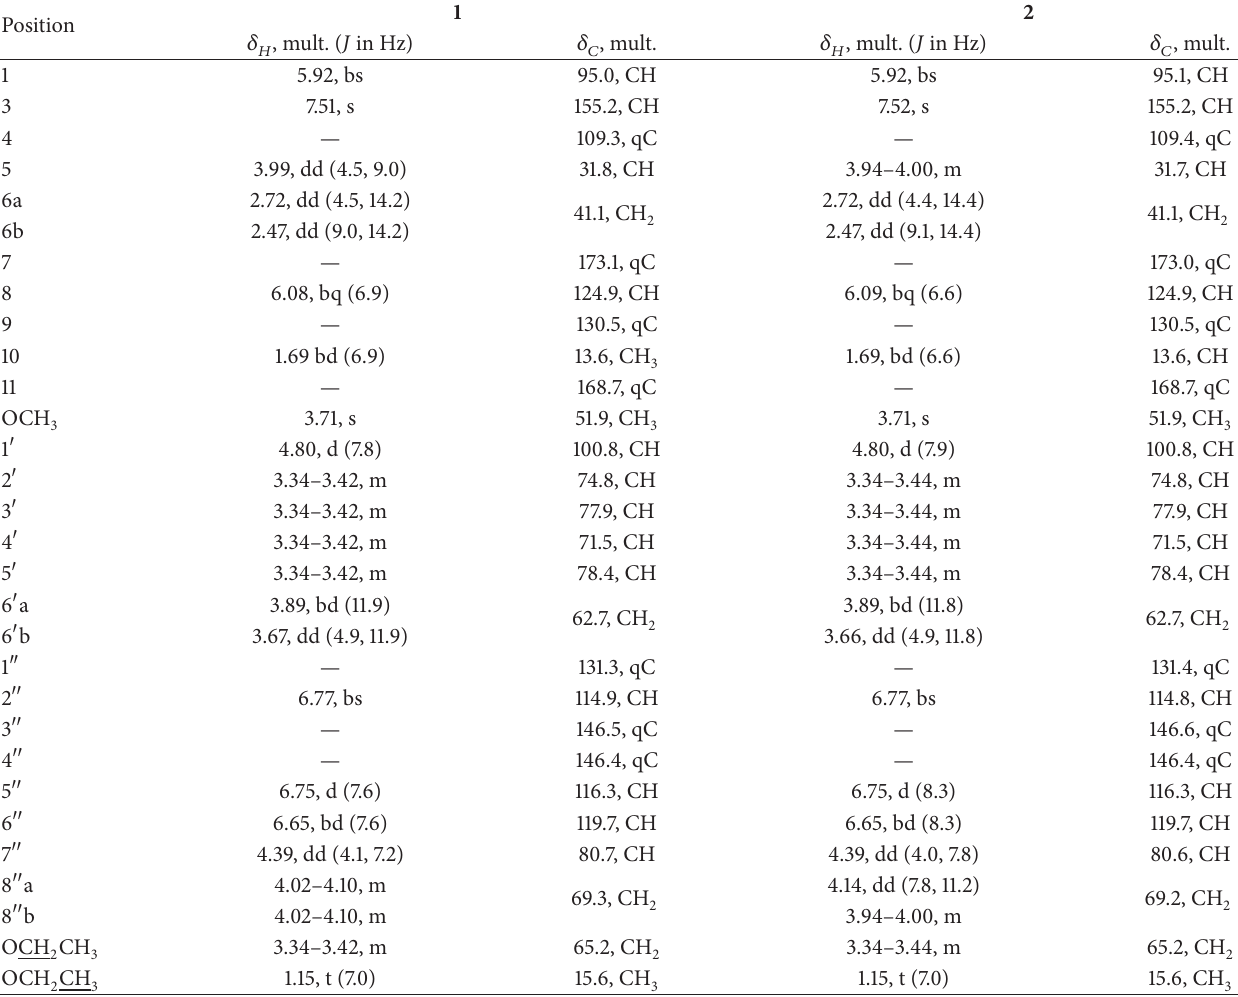
Table 1: NMR data (400MHz, CD OD) of (7 󸀠󸀠 R )-7 󸀠󸀠 -ethoxyoleuropein ( 1 ) and (7 󸀠󸀠 S )-7 󸀠󸀠 -ethoxyoleuropein ( 2 ). 3